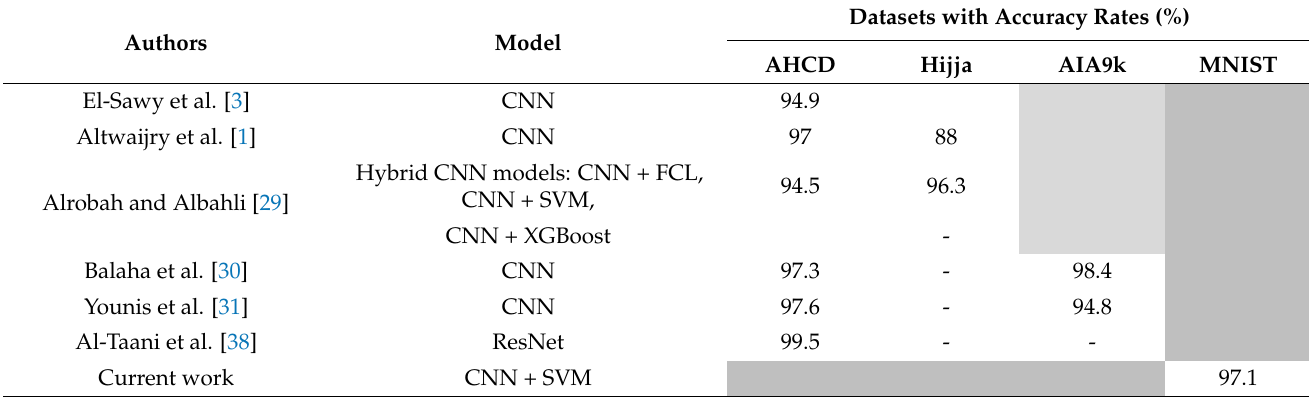
Table 11. Comparison with other